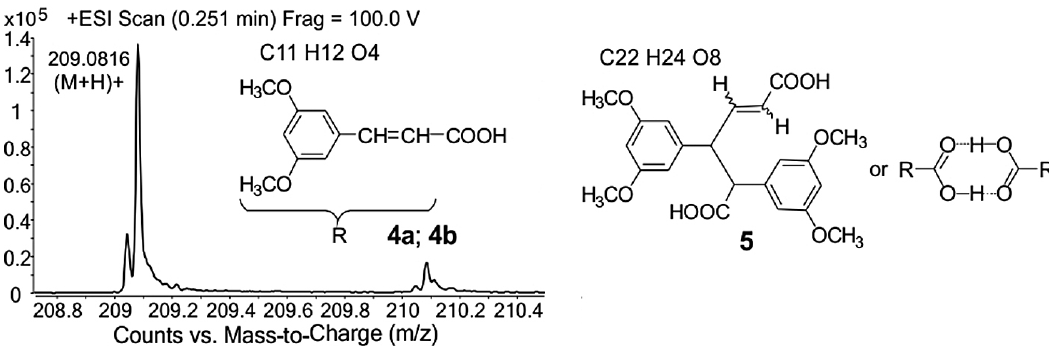
Figure 4. HRMS-ESI spectrum of the residue of 1f after irradiation showing characteristic signals of products 4a , 4b and 5